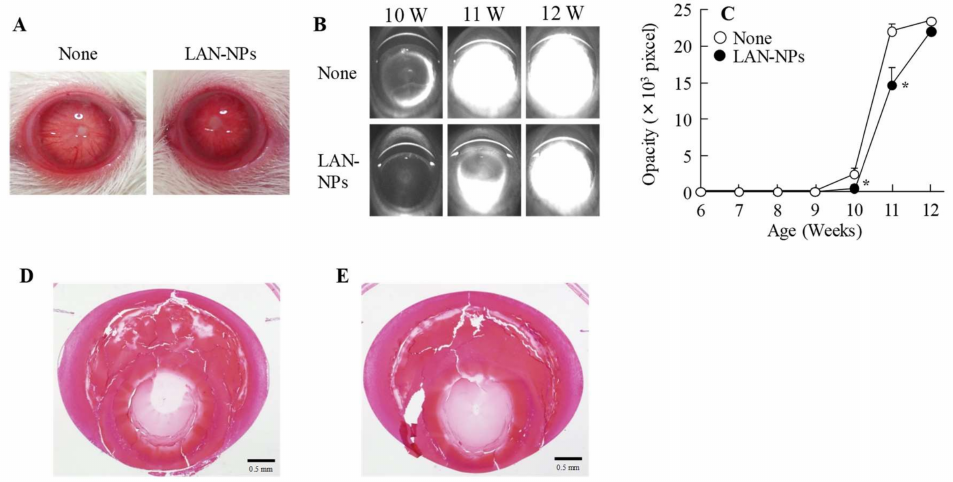
Figure 5. Eye images, Scheimpflug slit images, opacity levels, and H&E image of SCR-C after repetitive injection of LAN-NPs for 6 weeks. LAN-NPs were intravitreously injected into 6-week-old SCR-C, and the injections were continued for 6 weeks (once per 2 days). ( A ) Eyes of SCR-C intravitreously injected with or without LAN-NPs. ( B , C ) Scheimpflug slit (B) and opacification levels in SCR-C intravitreously injected with or without LAN-NPs. ( D ) H&E image of 12-week-old SCR-C intravitreously injected with LAN-NPs. ( E ) H&E image of 25-week-old SCR-C intravitreously injected with LAN-NPs. None, non-injected SCR-C; LAN-NPs, LAN-NP injected SCR-C; n = 6. * p < 0.05, vs. None for each group. No eye inflammation was observed in the SCR-C after the repetitive injection of LAN-NPs. LAN-NPs delayed but did not prevent the onset of opacification and showed remarkable changes in the lens structure, such as the posterior movement of the lens nucleus in SCR-C intravitreously injected with